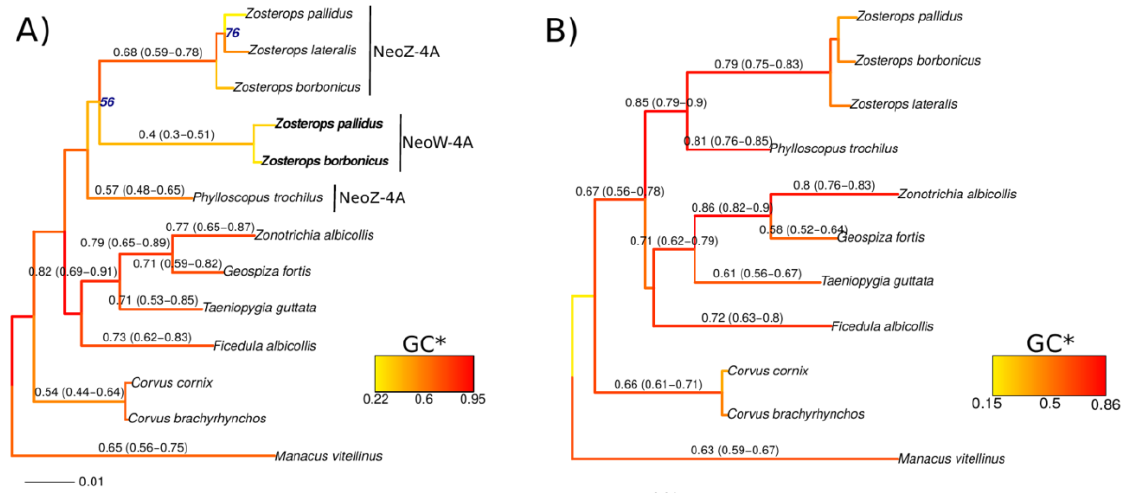
Figure 9 . Phylogenetic relationships and estimation of GC equilibrium (GC*). A) Estimation using the 17 genes coded by the translocated region of the ancestral chromosome 4A (0-9.6 Mb). Bold font indicates NeoW-4A sequences. B) Estimation using the 79 genes coded by the non-translocated region of the ancestral chromosome 4A (9.6-20.7 Mb). Branch color and numbers above branches indicated GC*, mean and 95% confidence interval obtained by bootstrap are in parenthesis. Number in blue in front of the node indicates ultra-fast bootstrap values lower than